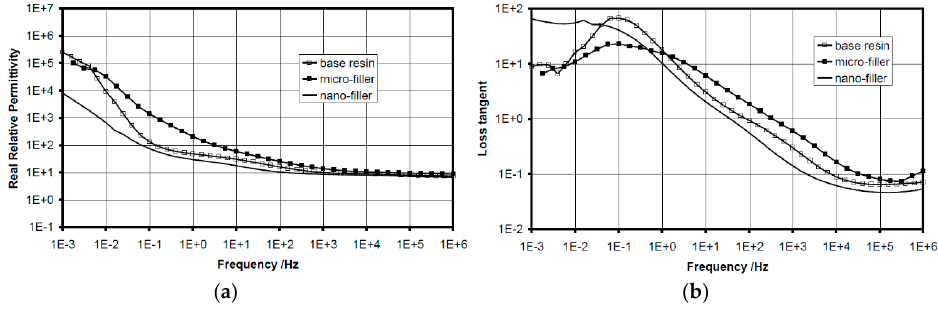
Figure 24. ( a ) Real part of relative permittivity and ( b ) loss tangent of unfilled epoxy resin and epoxy/10 wt % TiO 2 micro/nanocomposites materials at 393 K (© IOP Publishing. Reproduced with permission. All rights reserved [22]).